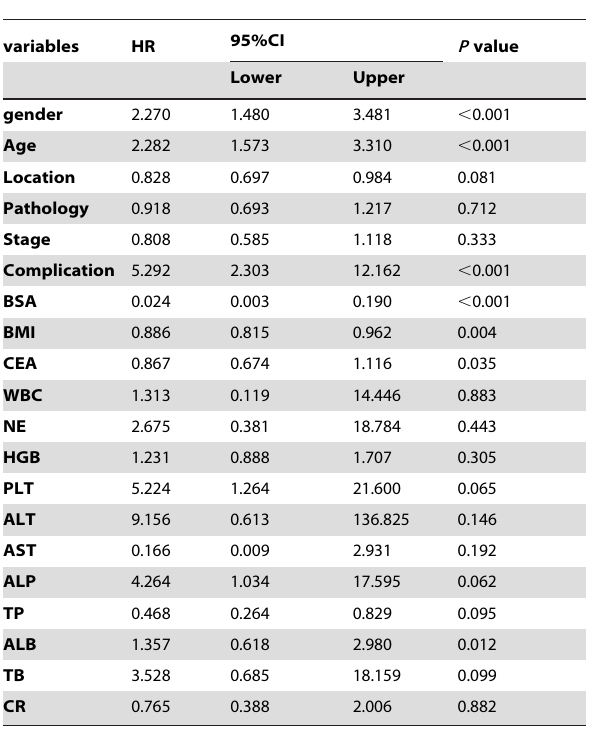
Table 5. Variables in the equation.